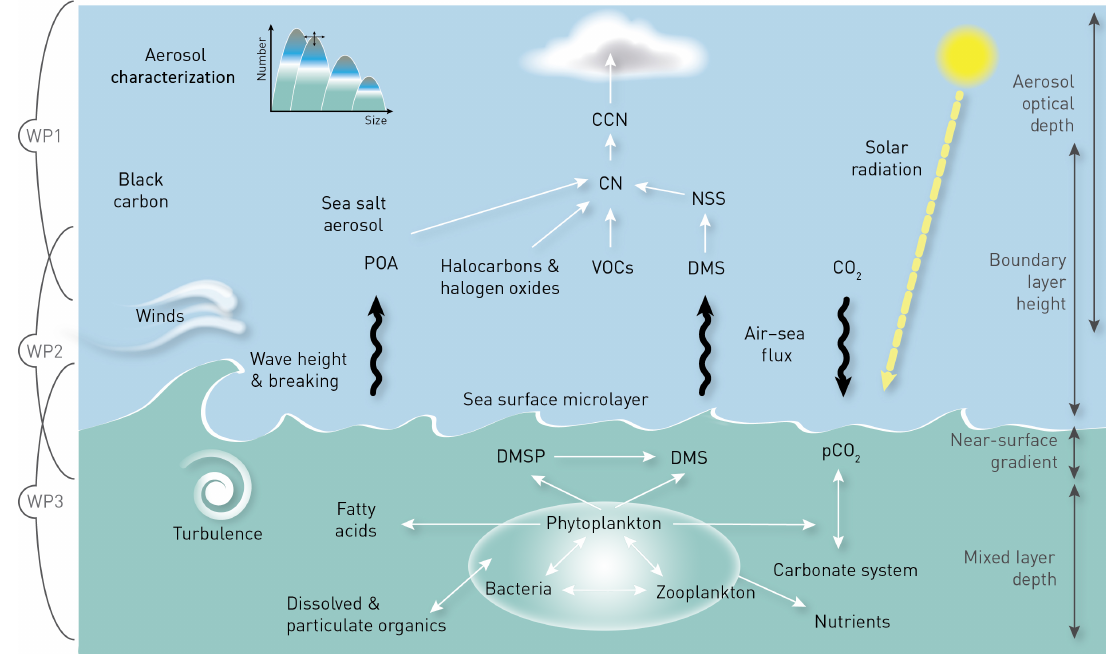
Figure 8. Conceptual figure of the parameters, processes and vertical range measured during SOAP, with the integrated work programmes (WP) indicated on the left of the figure. CN: condensation nuclei. NSS: non sea salt.